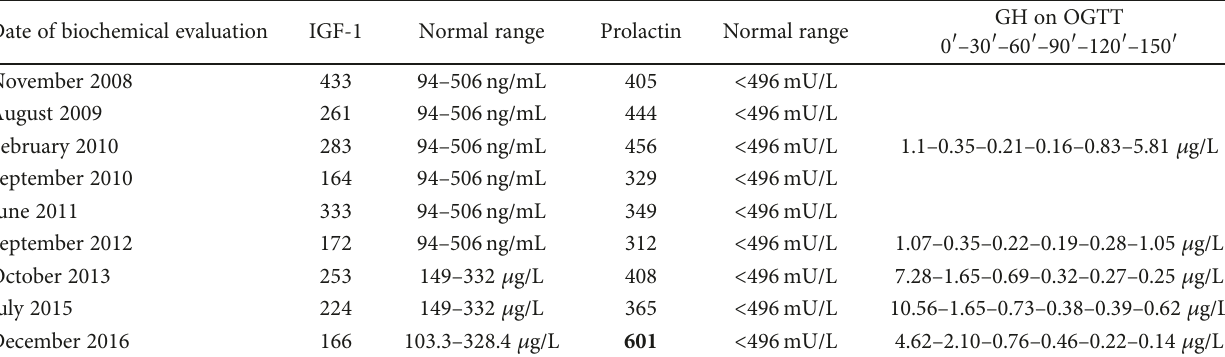
Table 2: Biochemical evaluation of the somatotrope and prolactin axes in the proband ’ s sister (case 3). Date of biochemical